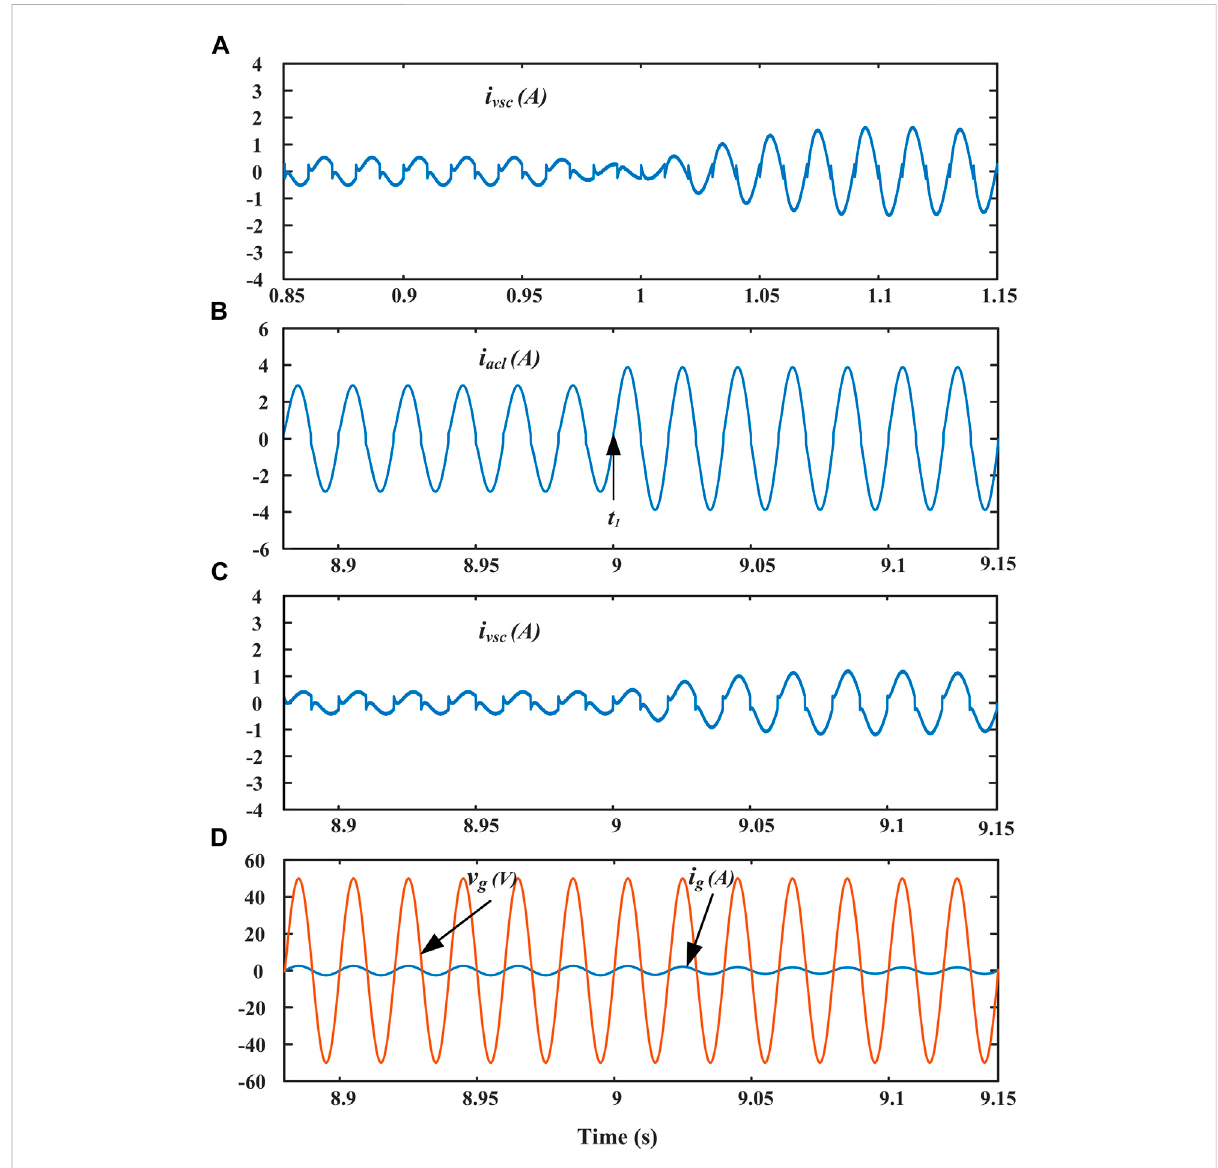
FIGURE 15 Features of power quality of the proposed